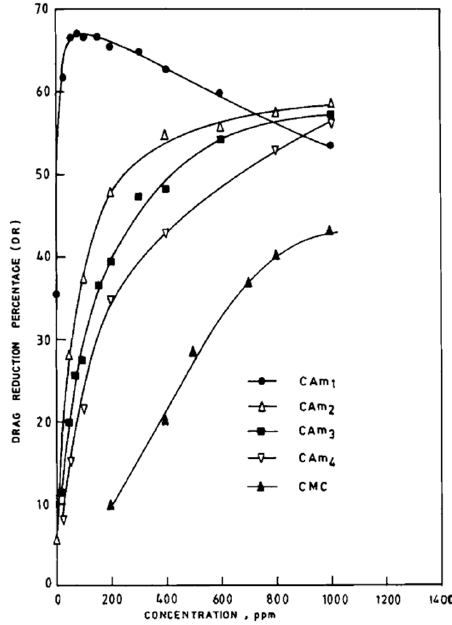
Figure 13. Drag reduction versus polymer concentration for carboxymethyl cellulose (CMC) and its graft copolymers, reprinted with permission from [89]. Copyright John Wiley and Sons, 1991.